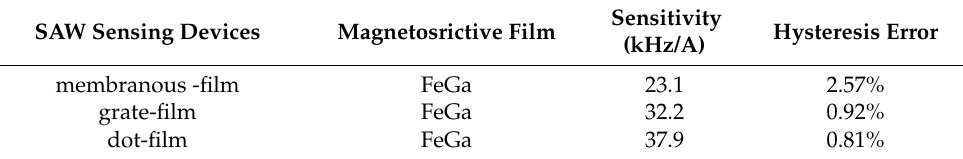
Table 1. The sensing performance of the proposed sensors in this work.